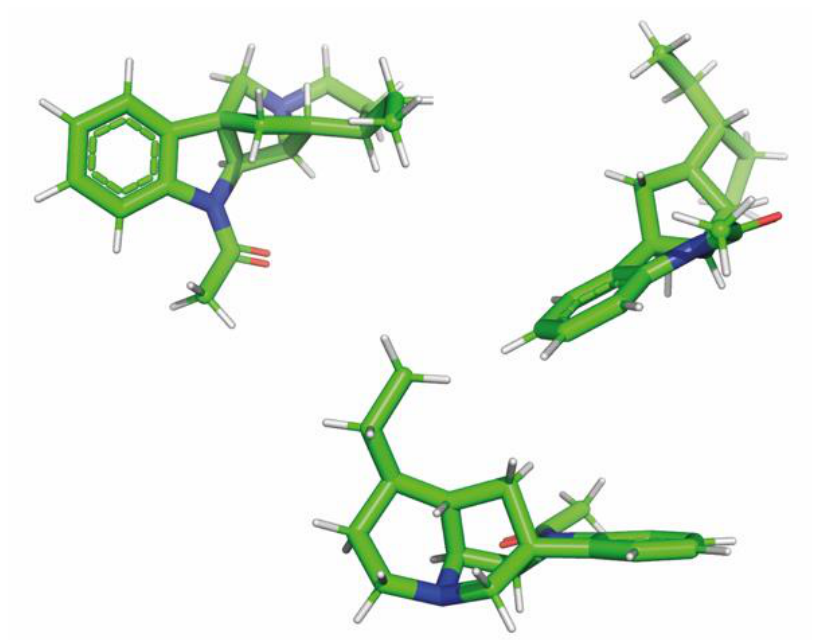
Figure 3. The lowest energy conformation of geissospermiculatine (optimized using HF/6-31G level of theory). Three different views of this conformation are shown.